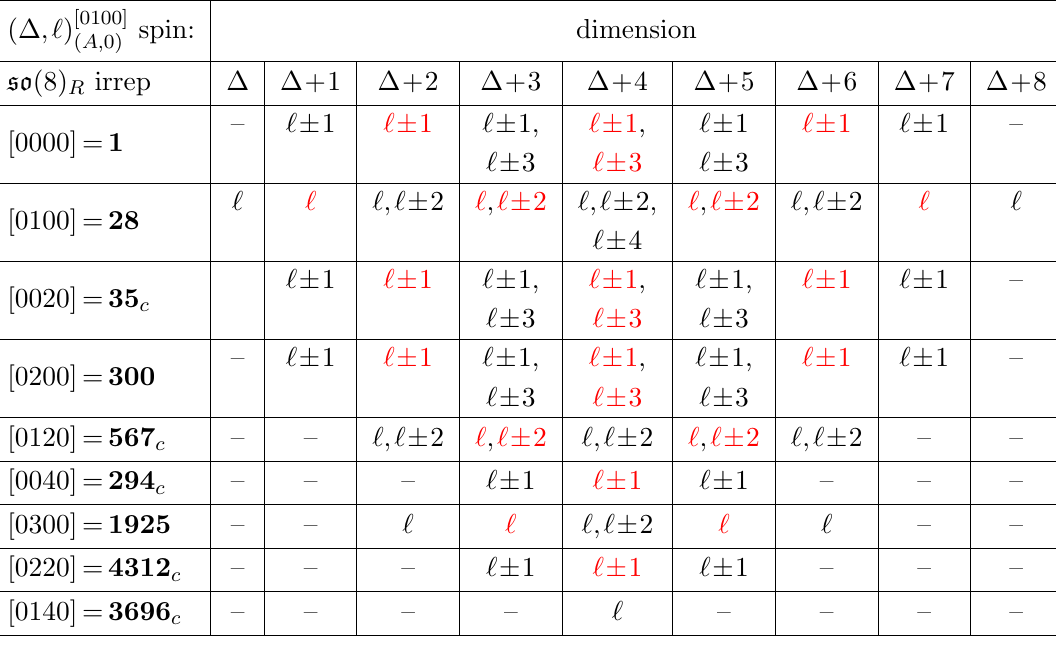
(cid:2)O 294 corresponding to the ((cid:1) ;‘ ) [0100] c c